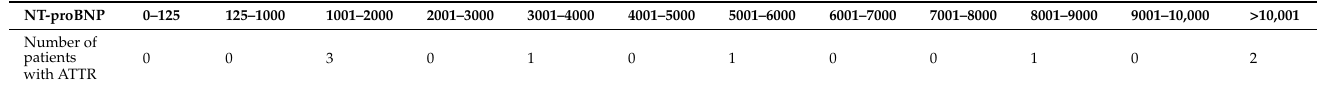
Table 6. NT-proBNP dosage for ATTR positive patients.